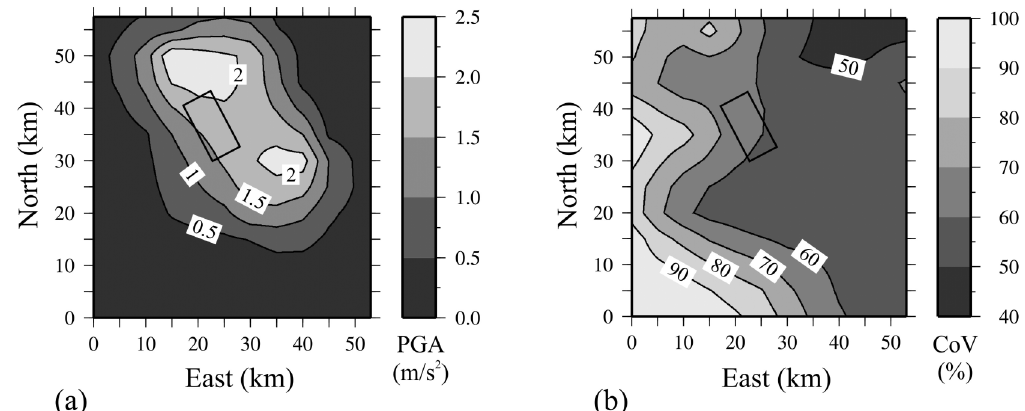
Fig. 9. (a) Map of simulated PGA (mean values). (b) Map of the Coefficient of Variation. Results were obtained by the ASM simulation technique. The rectangles in the figures represent the surface projection of the fault (modified after Convertito et al ., 2006).